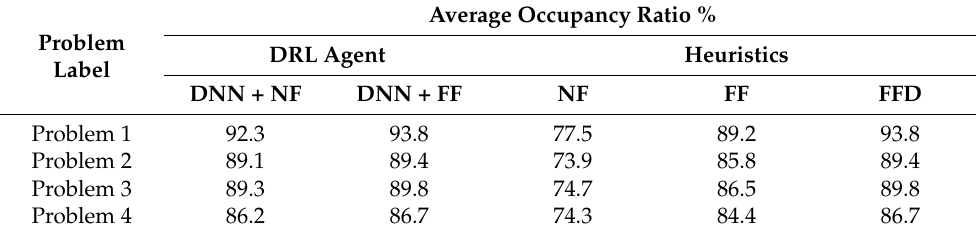
Table 2. Optimization performance experiments results. Avg. occupancy ratio (%) comparison between our trained DRL agents and the selected